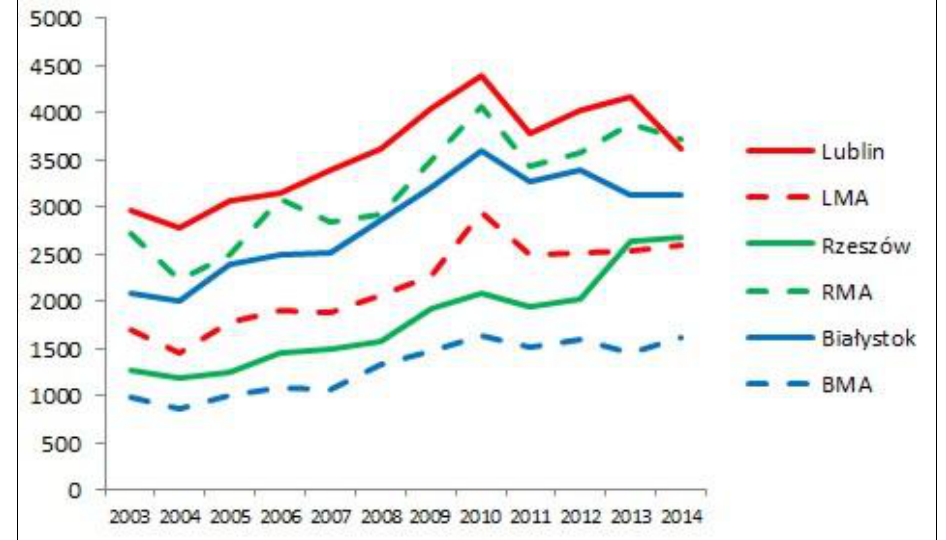
Fig. 9. Entities newly registered in the REGON